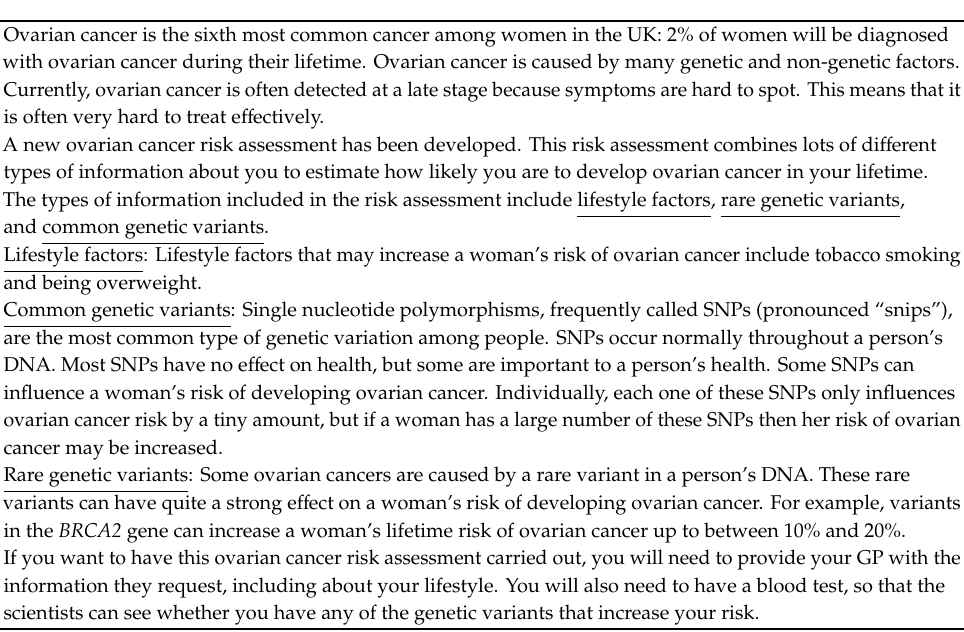
Table S1: Data for Figure 3, Table S2: Mean EPPM variables by experimental